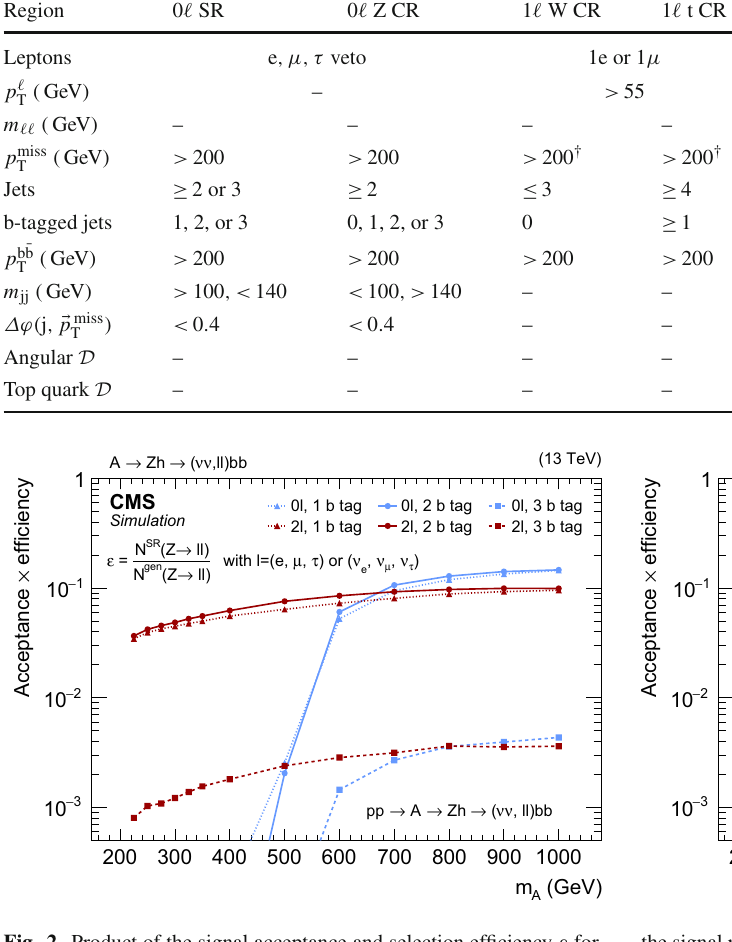
the signal region selections is denoted as N SR , and N gen is the number of events generated before applying any